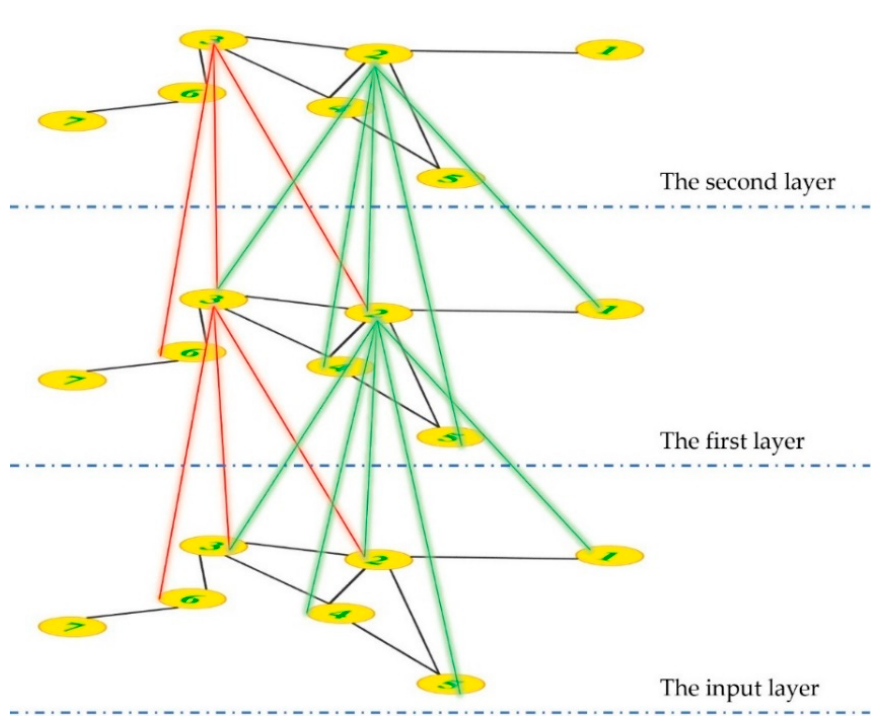
Figure 3. Illustration of information aggregation of GCN.